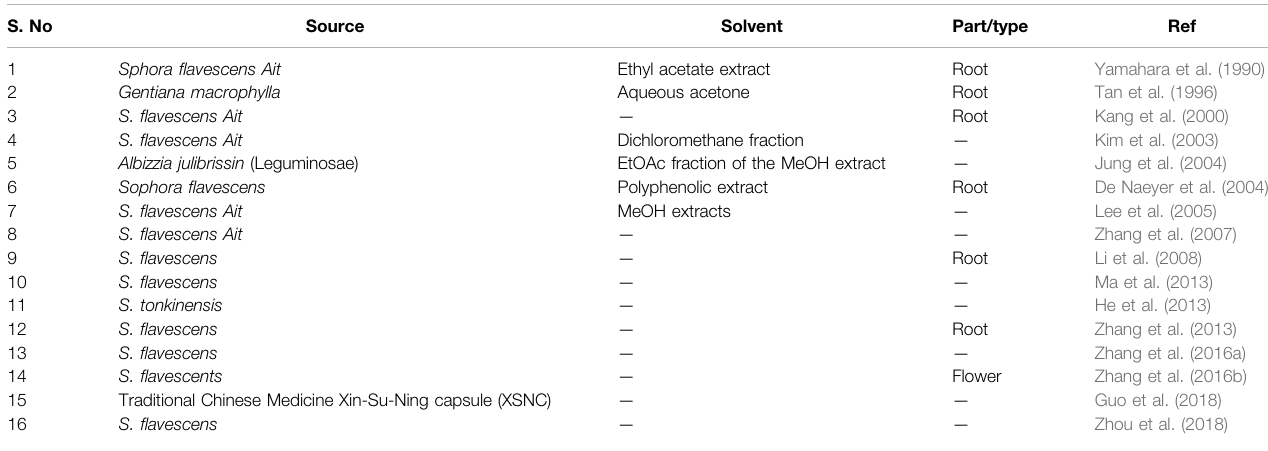
TABLE 1 | Kurarinone isolation from different